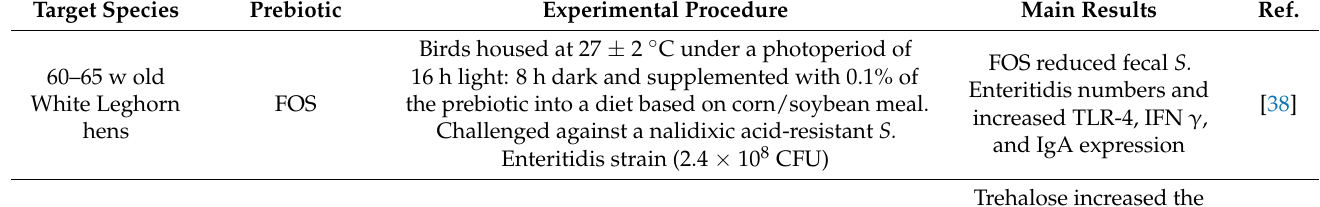
Table 1. Effects of dietary supplementation of prebiotics as a strategy to control Salmonella in poultry. Experimental Procedure Main